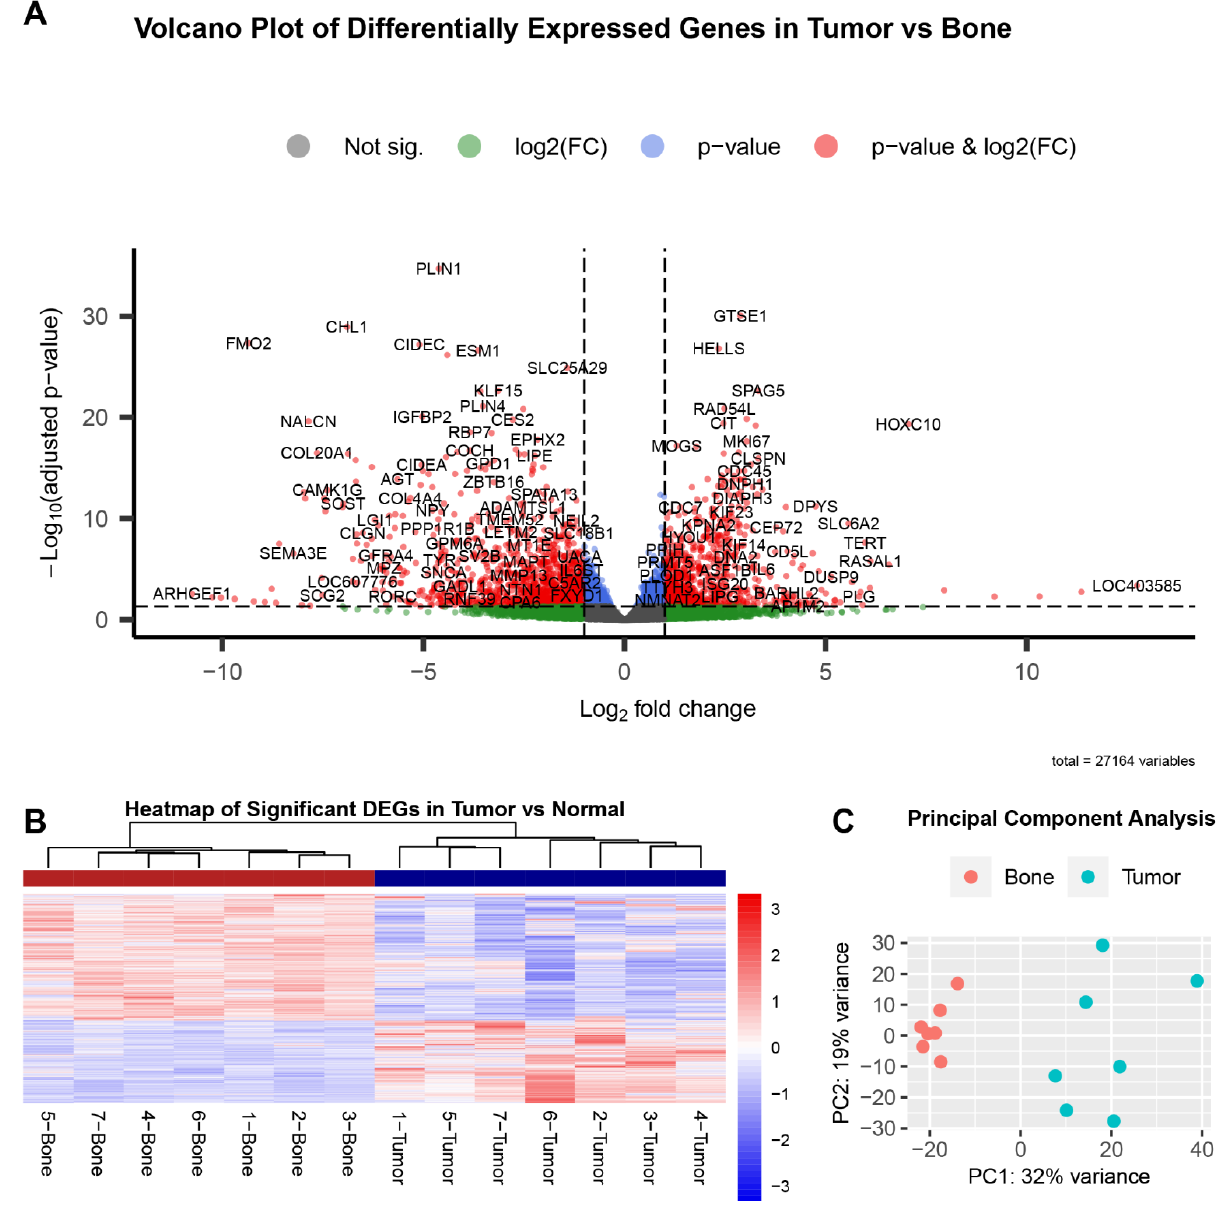
Figure 2. Analysis of differential gene expression in tumor vs normal group data reveals over 3000 significant DEGs. Volcano plot shows many genes are highly differentially expressed between tumor vs. normal ( A ). Genes indicated in red are significant in terms of both adjusted p -value (<0.05) and fold-change (>2 and ≤2). The sign of fold-change (positive or negative) was retained and is reported in terms of tumor compared to bone. Heatmap of the significant genes (FDR < 0.05) shows that these DEGs easily differentiate tumor from normal tissue ( B ). Each row represents a gene and upregulation is indicated in red, while downregulation is shown in blue. Patient and sample ID is indicated underneath the corresponding column. PCA plot shows grouping of normal bone samples (red circles) distinct from tumor samples (blue circles) as expected ( C ). The dispersion and variability of the tumor samples is thought to be related to intra- and inter-tumoral heterogeneity. Principal component analysis was performed to further evaluate sample clustering (Figure 2C). As expected, all bone samples clustered together, distinct from the tumor samples.